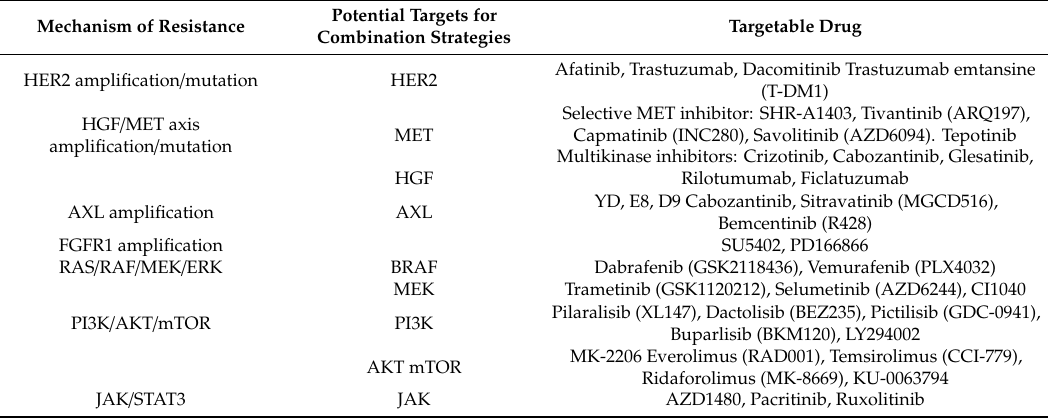
Table 2. Drugs in use or in development for acquired resistance